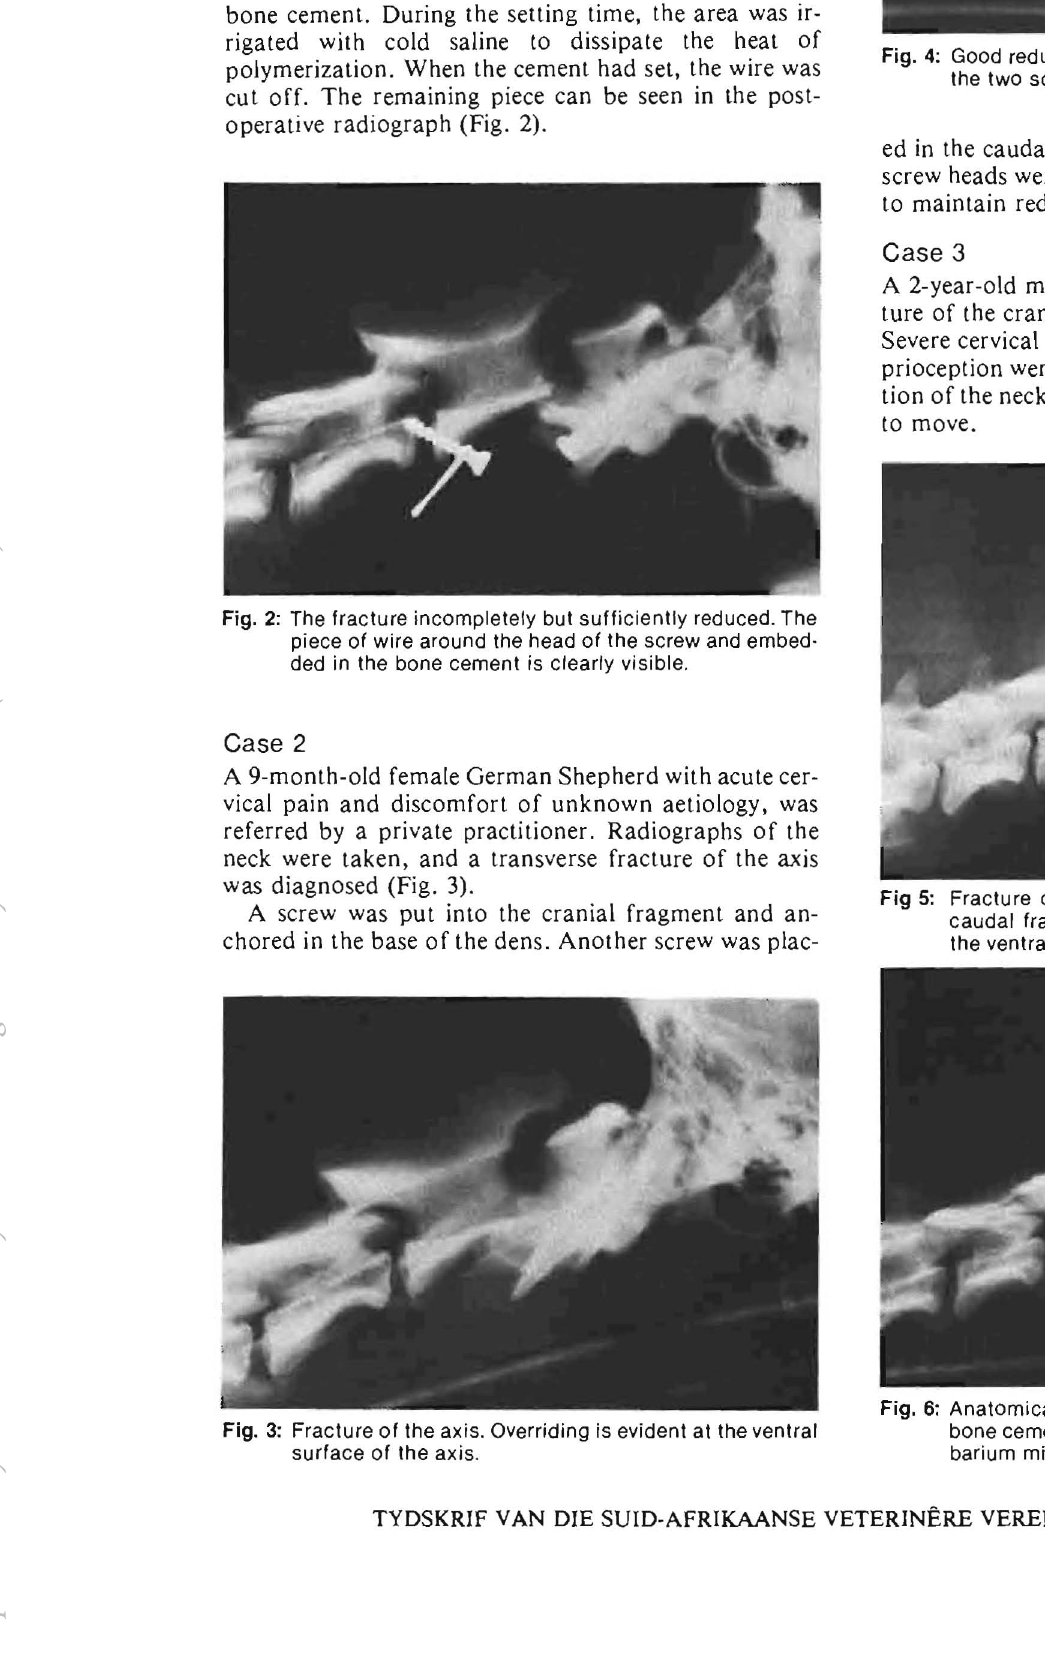
Fig. 6: Anatomical reduction has been achieved. The mass of bone cement is radiopaque because of the presence of barium mixed with the bone